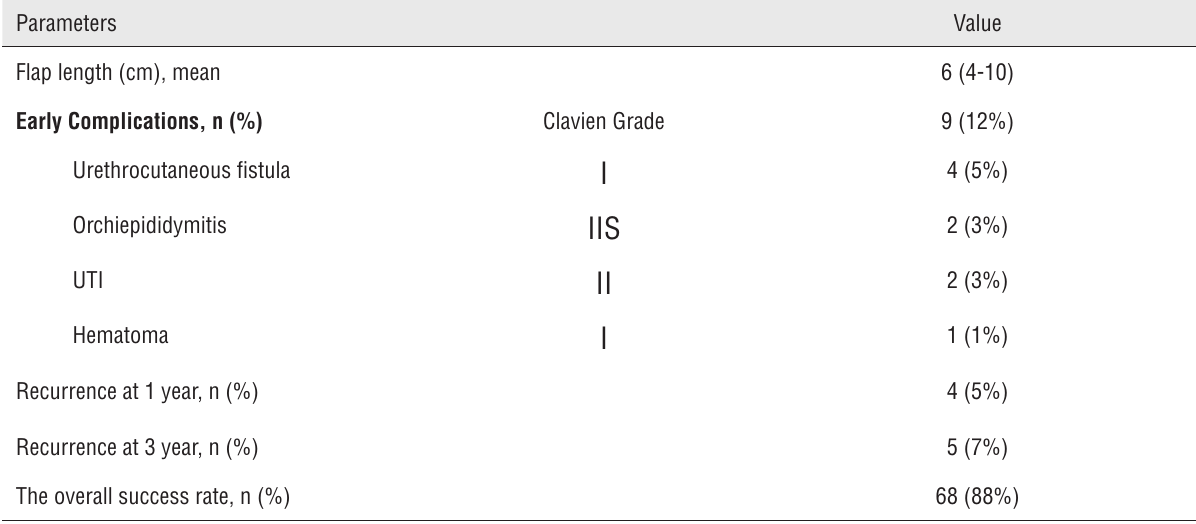
Table 2 - Operative and follow-up